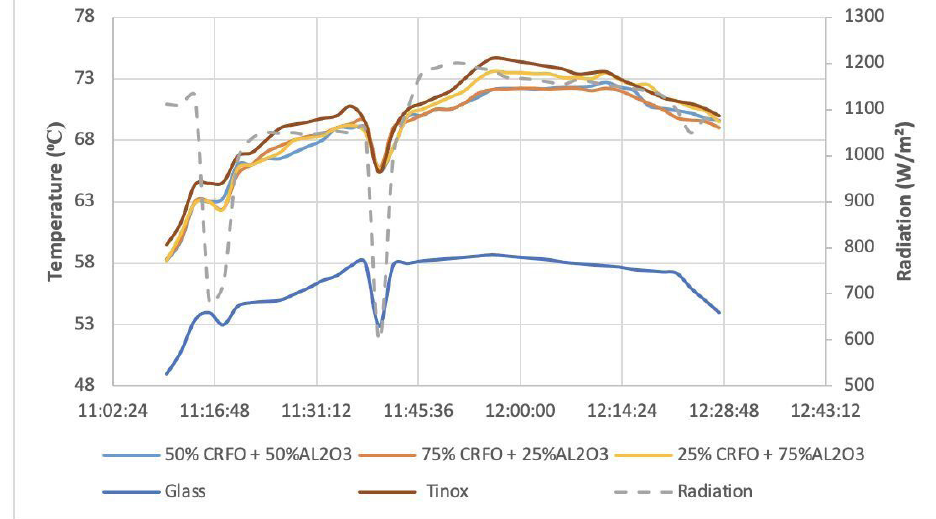
Figure 13. Results of the field test.